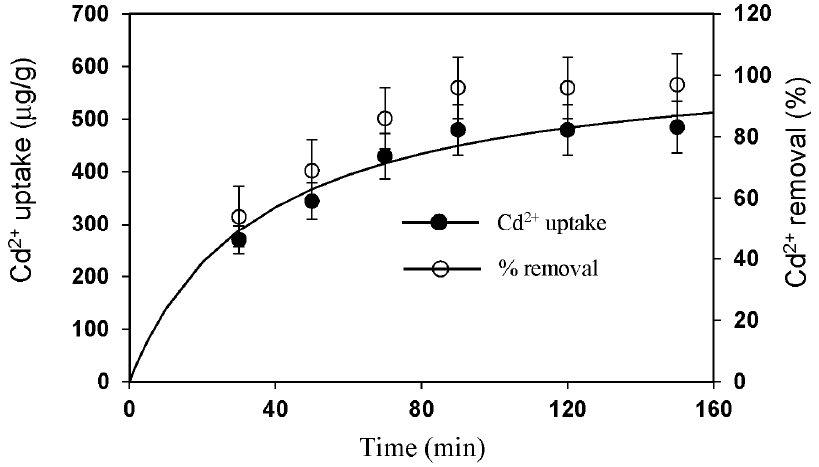
Figure 8. Kinetics of Cd 2+ uptake and removal.